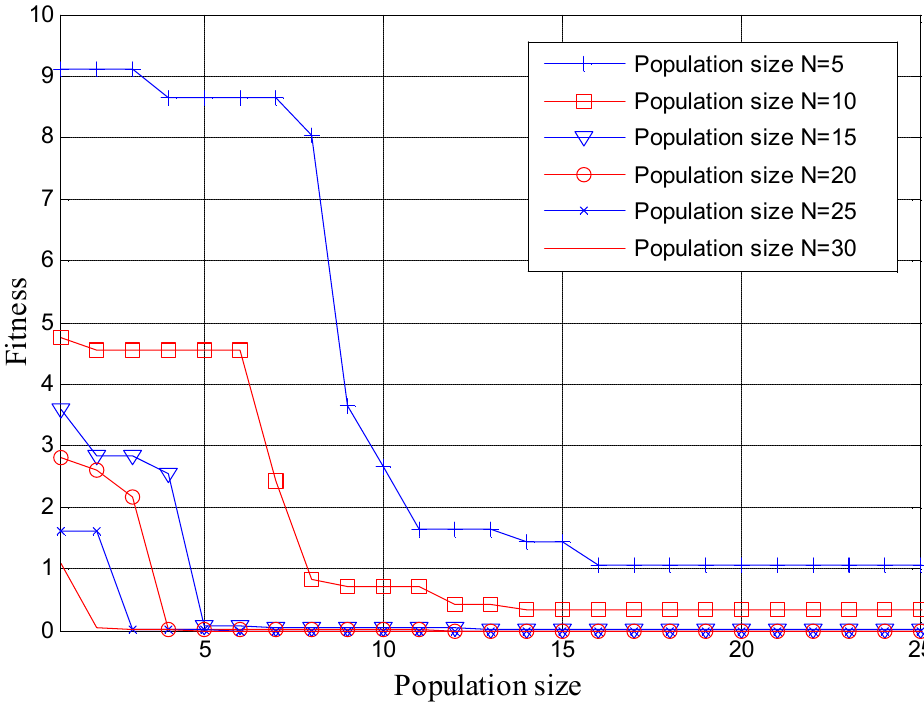
Figure 7. Effect of population size on fitness.